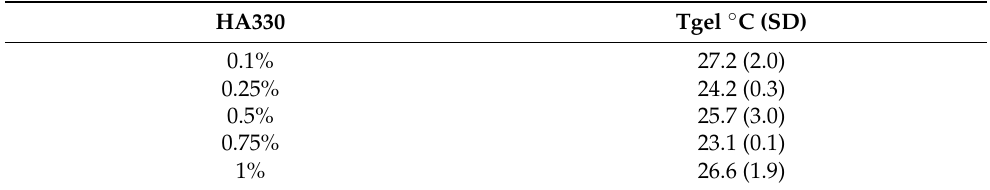
Table 2. Effect of the HA330 concentration on the Tgel of different empty TSH formulations with 15% P407.